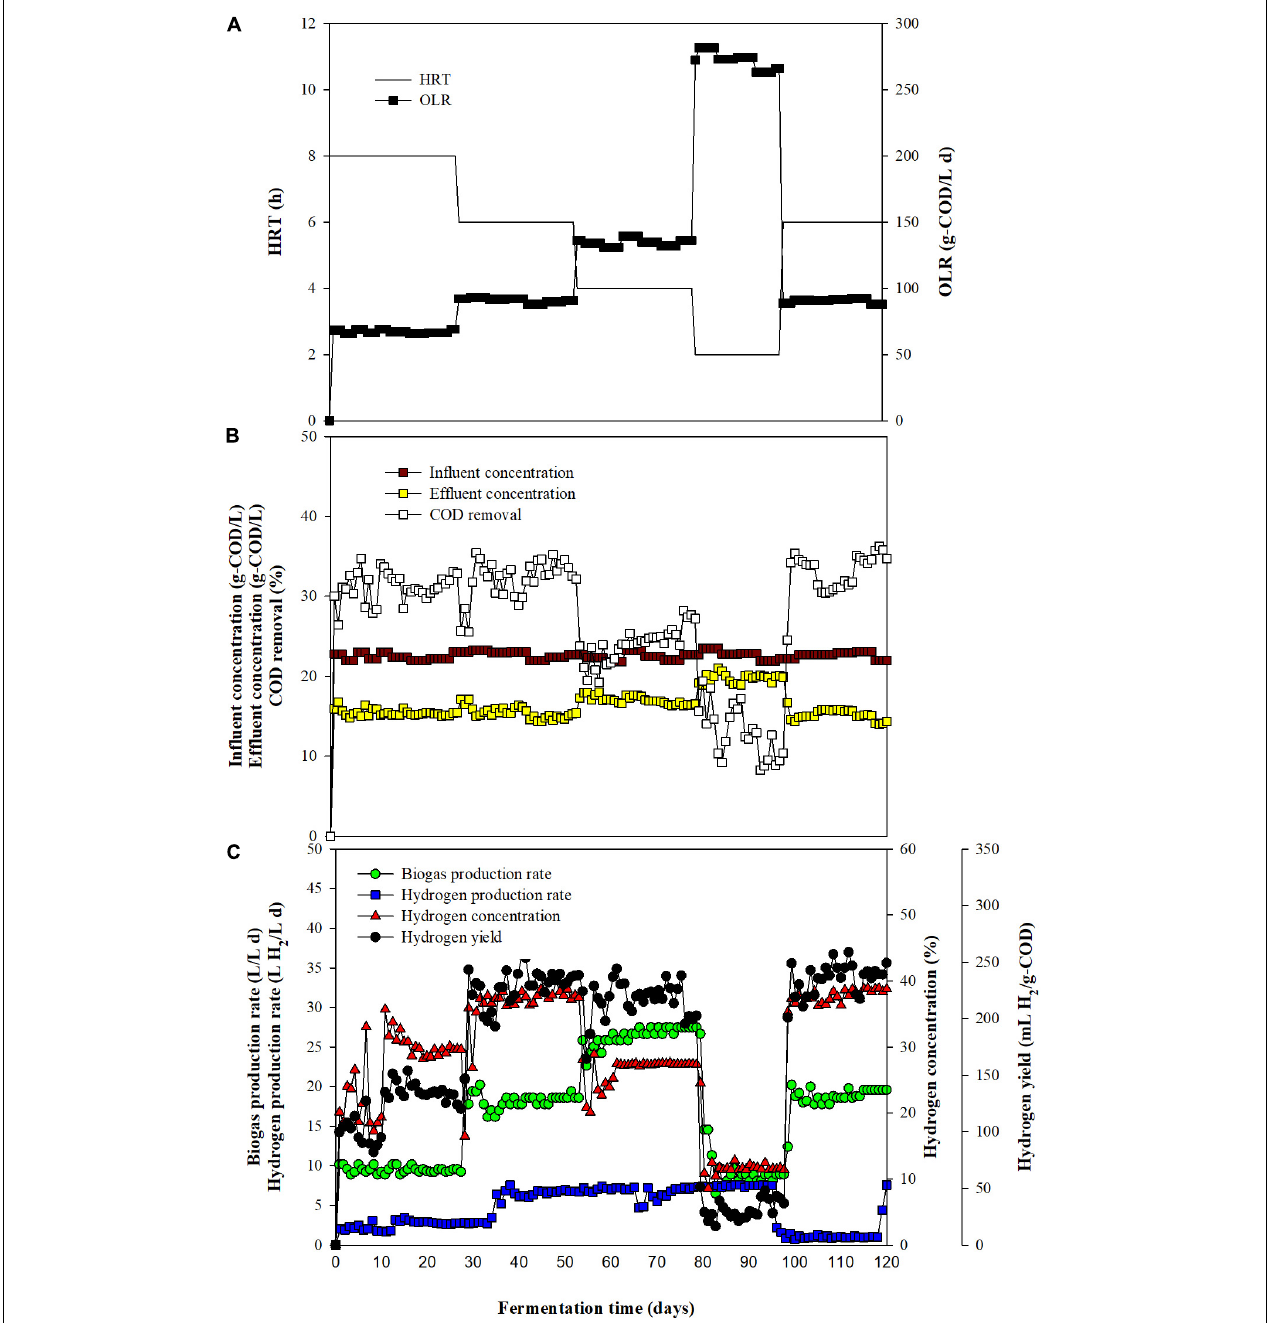
FIGURE 2 | Effect of hydraulic retention time (HRT) on the performance of a fixed-bed reactor fed with oil palm trunk hydrolysate and slaughterhouse wastewater. (A) HRT and organic loading rate (OLR); (B) chemical oxygen demand (COD) removal, influent, and effluent concentrations, and (C) biogas production rate, hydrogen production rate, hydrogen concentration, and hydrogen